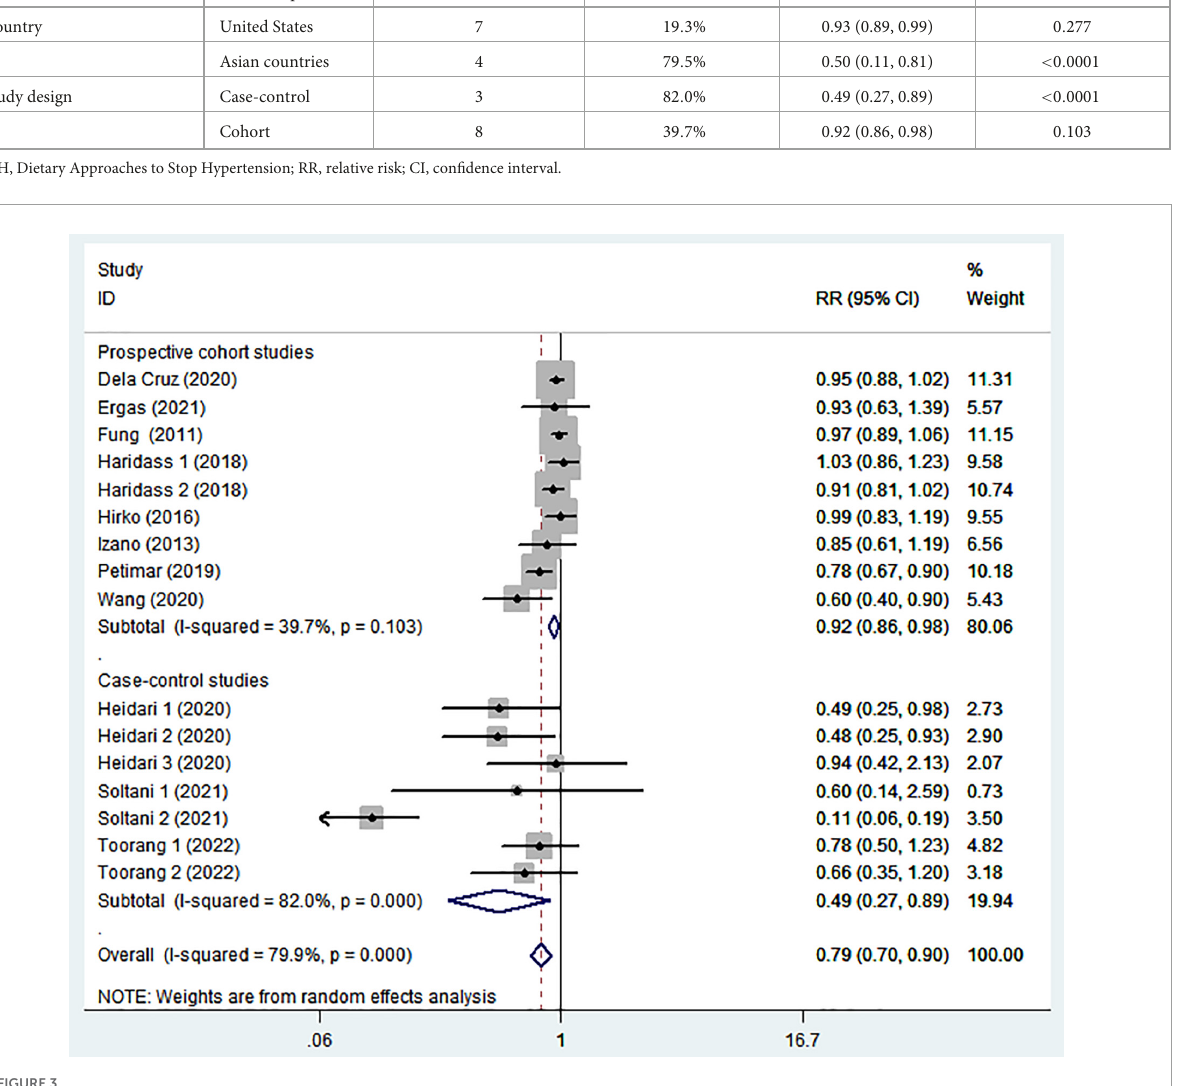
I 2 = 94.5%). Similarly, we also performed stratified analysis based on comparison in Figure 6 . Among Q4 vs. Q1 comparison studies only, there was more heterogeneity ( P < 0.00001, I 2 = 90.6%), and a significantly decreased risk of breast cancer was shown (RR = 0.48; 95% CI: 0.24, 0.98; P = 0.045). In Q5